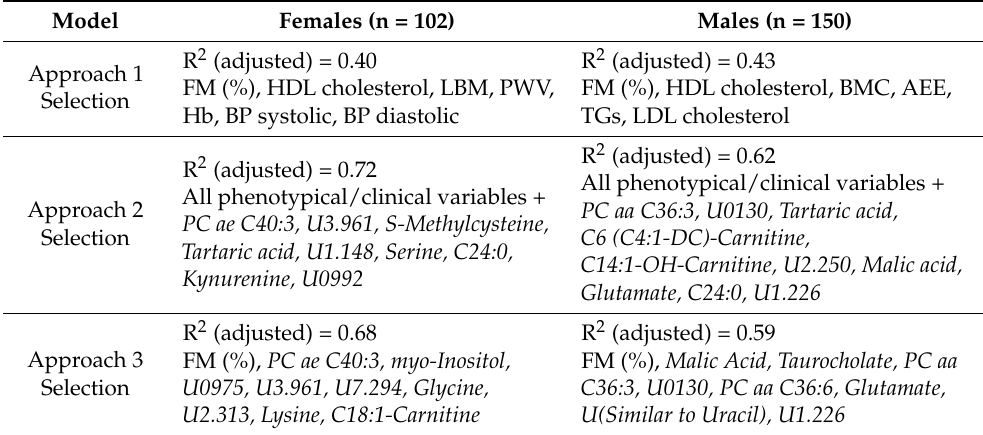
Table 3. Summary of sex-specific final models for the confounder-adjusted VO 2peak